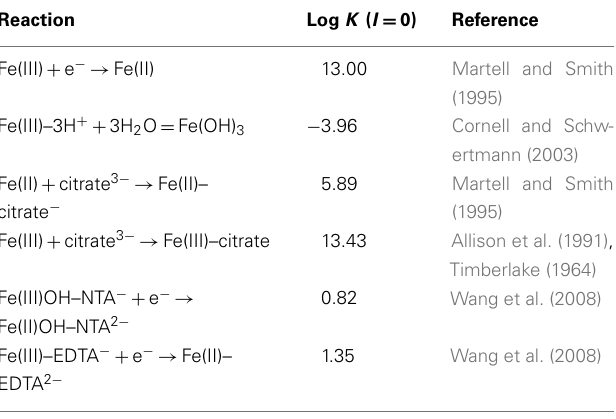
Table 2 | Relevant speciation reactions for calculating reaction-free energy at 25˚C.